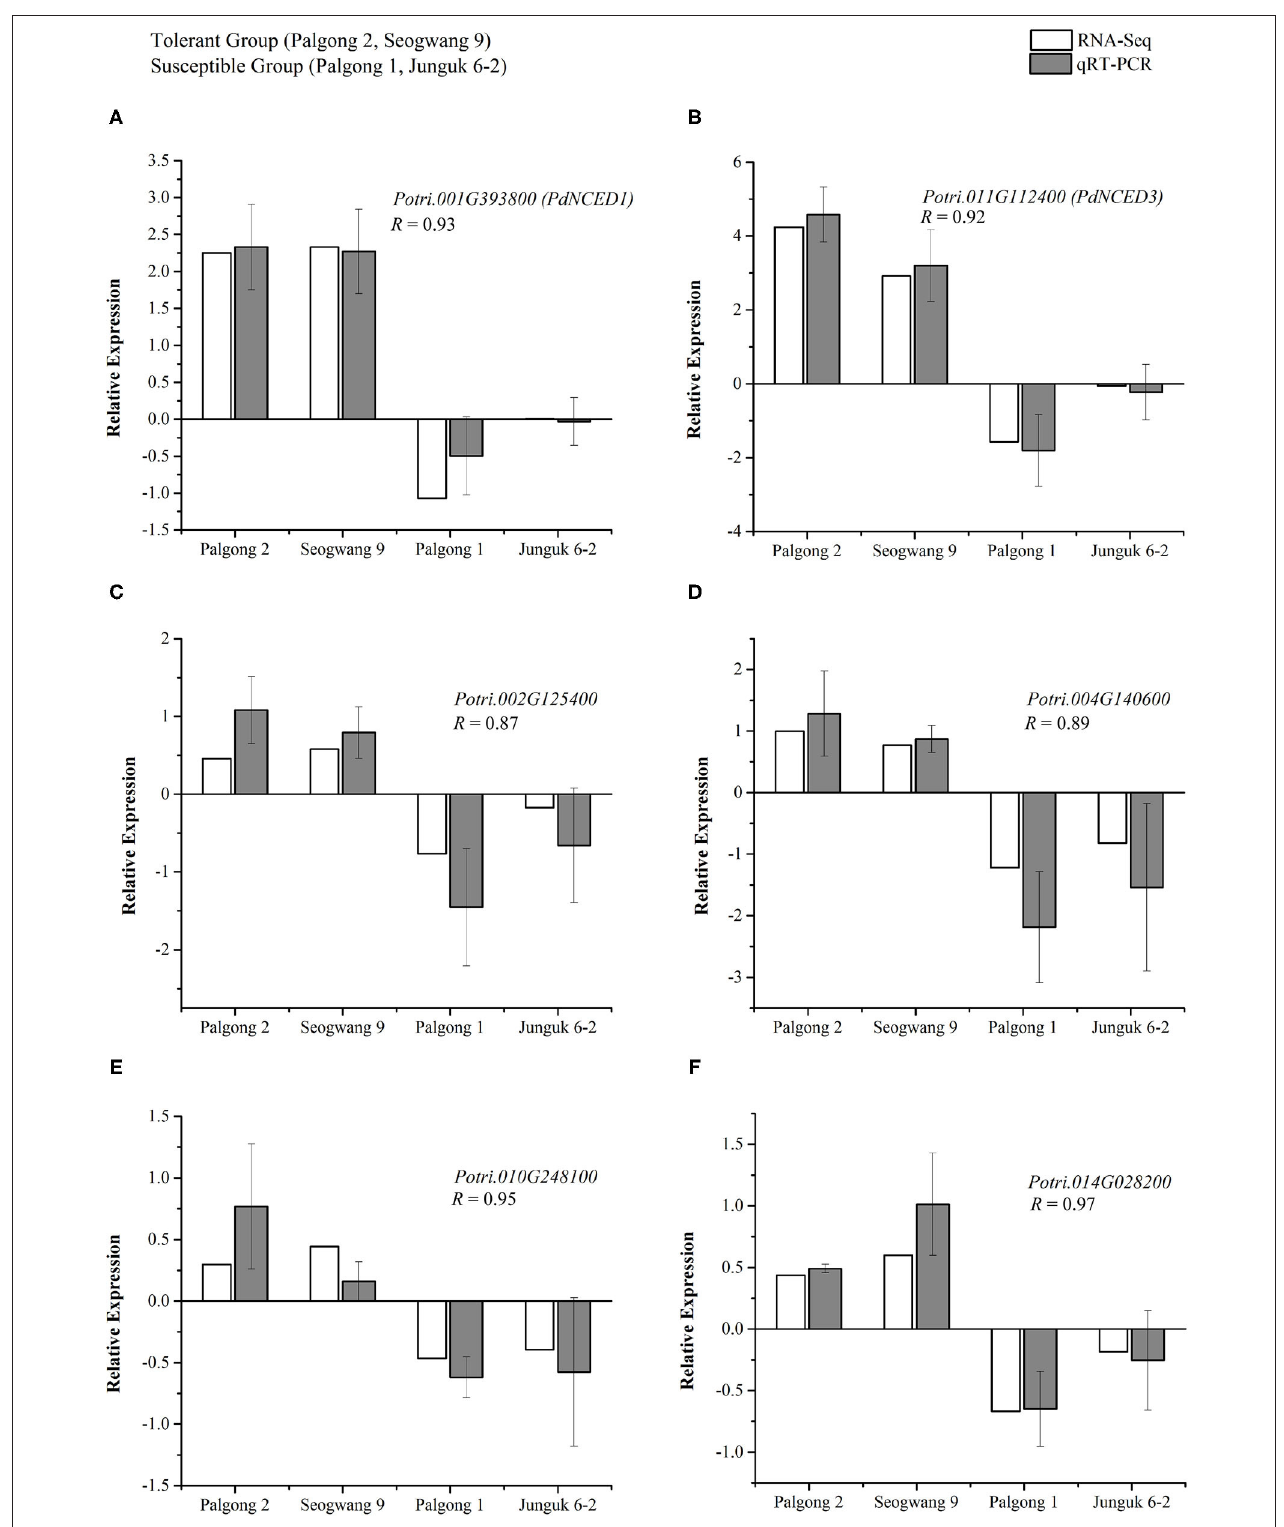
FIGURE 7 | Validation of the expression patterns of drought-specific genes in P. davidiana following dehydration stress through qPCR. The two drought-responsive NCED genes; PdNCED1 ( Potri.001G393800 ) and PdNCED3 ( Potri.011G112400 ) were upregulated in the drought-tolerant cultivars Palgong2 and Seogwang 9